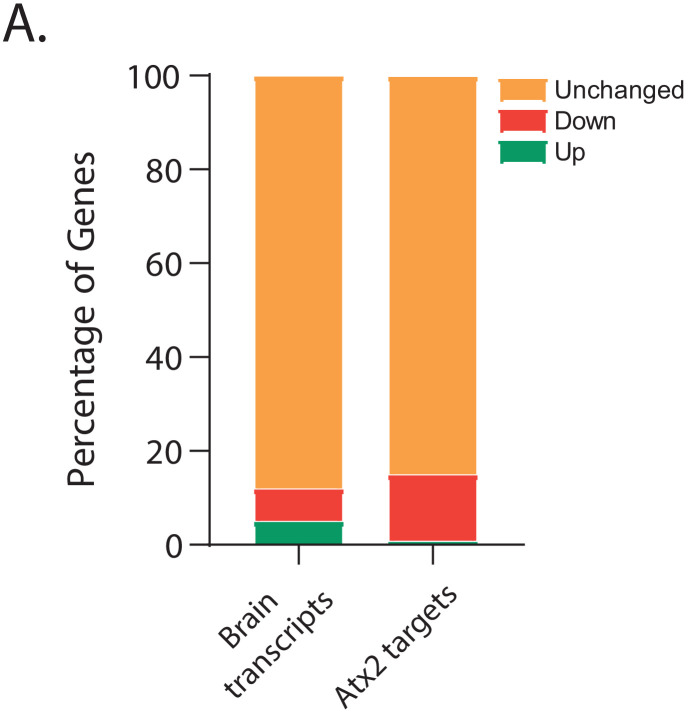
Differential expression analysis of intron reads from control and Atx2 RNAi show no major reduction in levels of Atx2 Targets of RNA-Binding Proteins Identified by Editing nascent mRNA targets.
Figure 3—figure supplement 3—source data 1.Fold changes in the introns of Atx2-target mRNAs upon Atx2 RNAi.